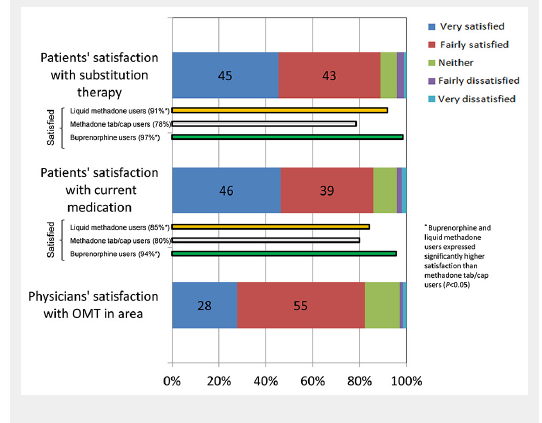
A summary of satisfaction with current medications and opioid maintenance therapy (OMT). The patients’ satisfaction was further stratified according to medications used.